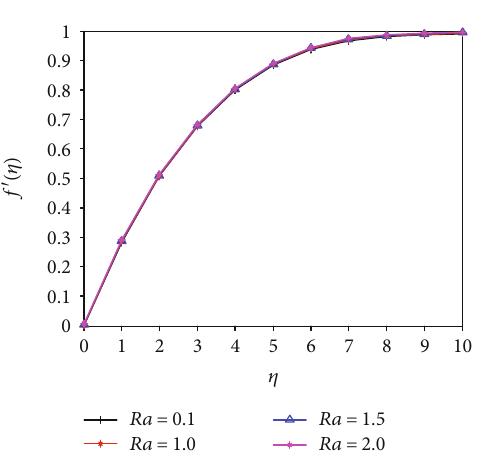
Figure 1: Velocity pro fi les for varied values of Pr once Gr = λ = M = Bi = Ra = 0 : 1 .